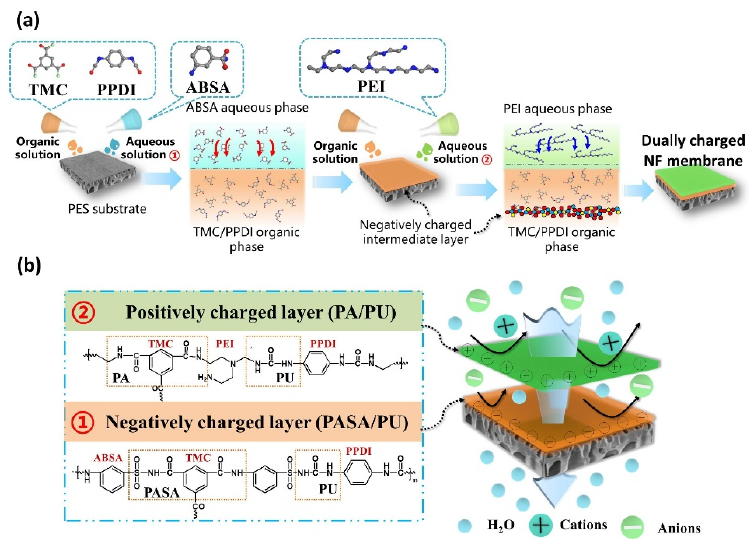
Figure 4. Diagram of ( a ) the fabrication process of the dually charged membrane via r-IP method and ( b ) the separation layer structure and separation mechanism [96]. Table 1. Regulation method and acid stability of PA NF membranes.